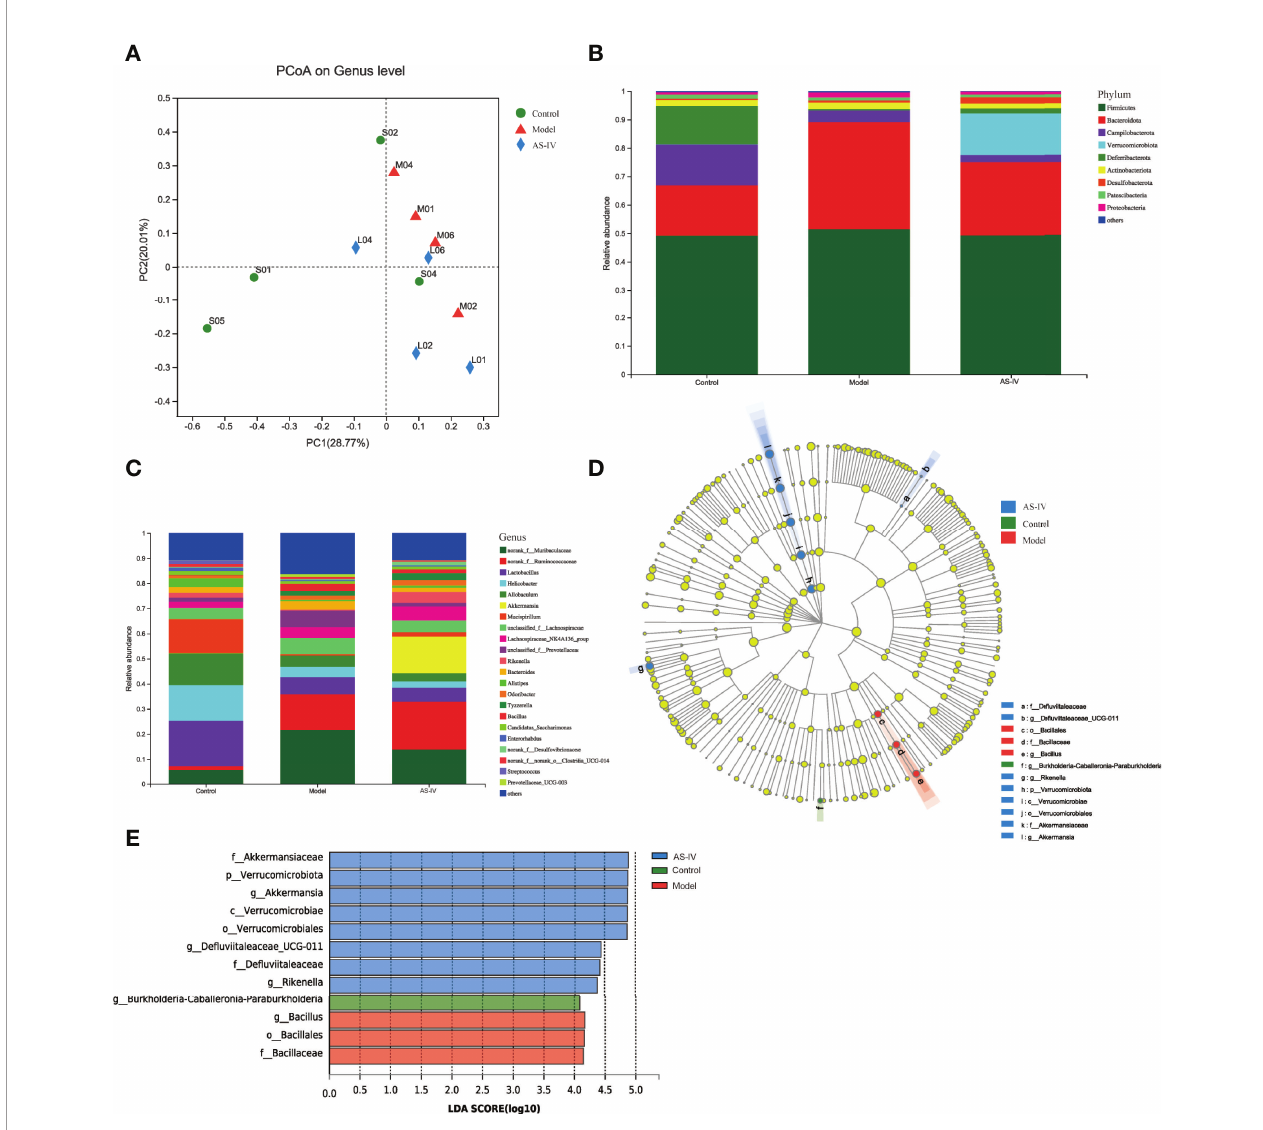
FIGURE 5 | Effects of AS-IV on the structure of microbiota. (A) Principal coordinate analysis (PCoA). (B, C) Relative abundance of intestinal microbes at the phylum and genus level, respectively. (D) Taxonomy cladogram. (E) Gut microbial taxa (LDA threshold of